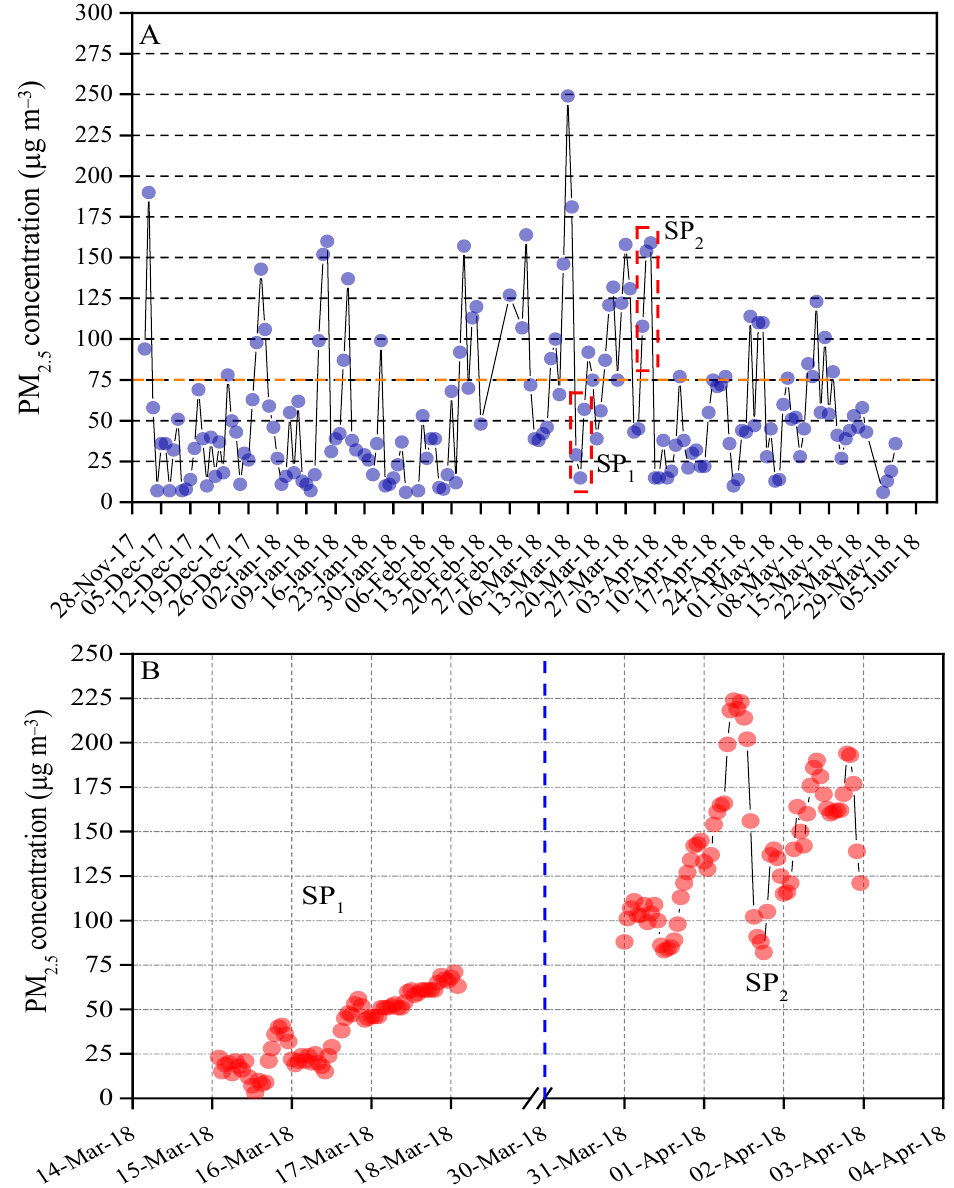
Figure 2. ( A ) Daily mass concentration of PM 2.5 from 1 December 2017 to 31 May 2018. 75 µg m −3 is the 24 h value limit of PM 2.5 recommended by Ambient Air Quality Standards in China (GB 3095-2012). ( B ) Hourly mass concentration of PM 2.5 from 15 to 18 March 2018 (SP 1 ) and 31 March to 2 April 2018 (SP 2 ), respectively.